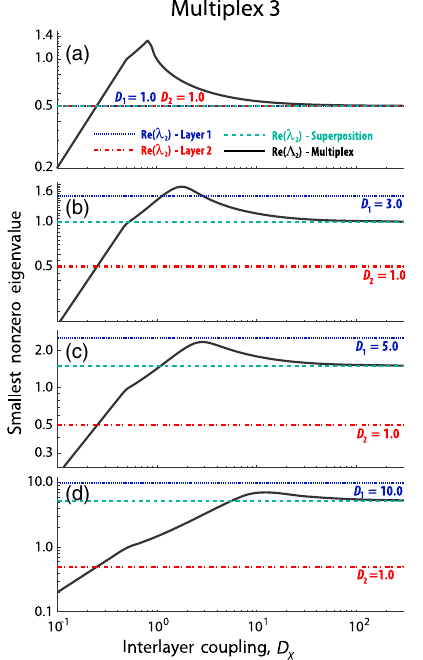
FIG. 7. Characteristic rate of convergence to stationary state solution of a continuous-time Markov chain in multiplex 3 for different pairs ð D 1 ; D 2 Þ . The value of the smallest (in terms of its real part) nonzero eigenvalue ð Λ 2 Þ of the supra-Laplacian is displayed as a function of interlayer coupling D X